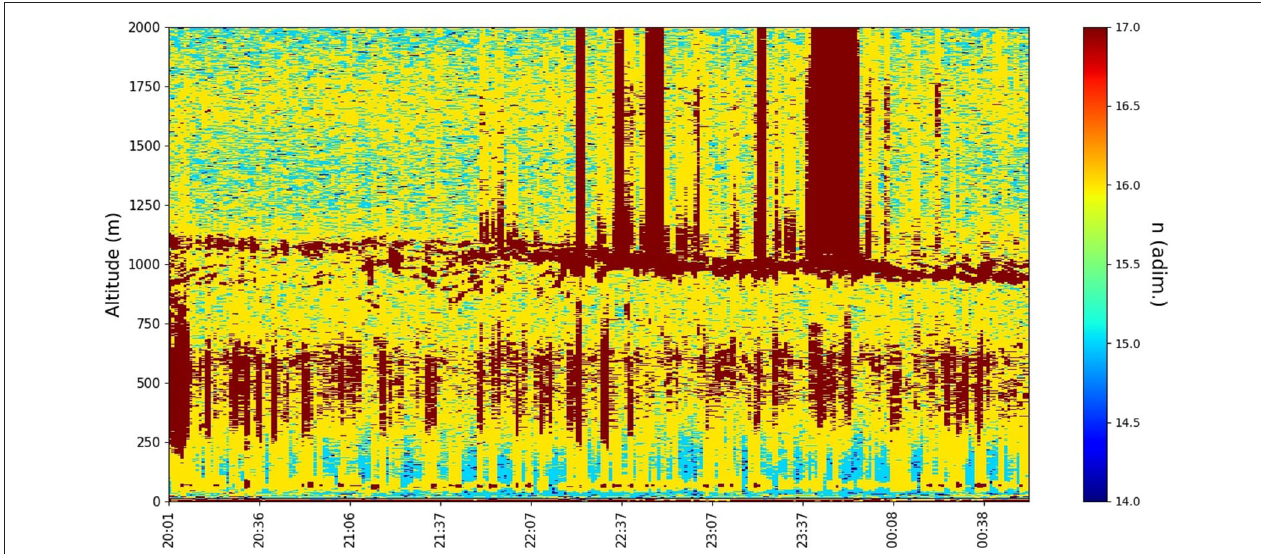
FIGURE 9 | n ( z ) timeseries on the 28th of May 2017 calculated with multifractal theory and lidar-obtained length scales; temporal resolution: 3min; spatial resolution: 3.75m.